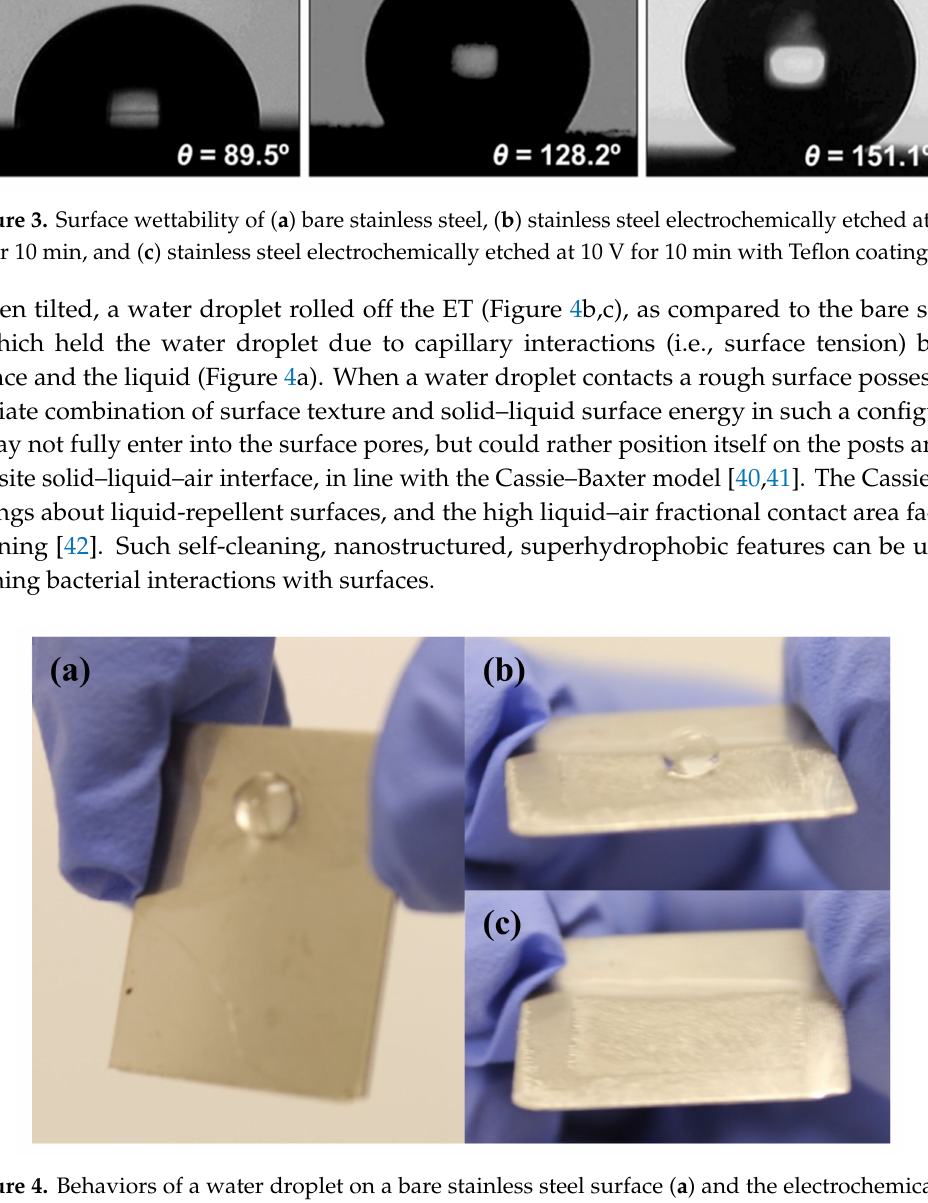
Figure 4. Behaviors of a water droplet on a bare stainless steel surface ( a ) and the electrochemically etched surface with Teflon coating ( b ), ( c ) when